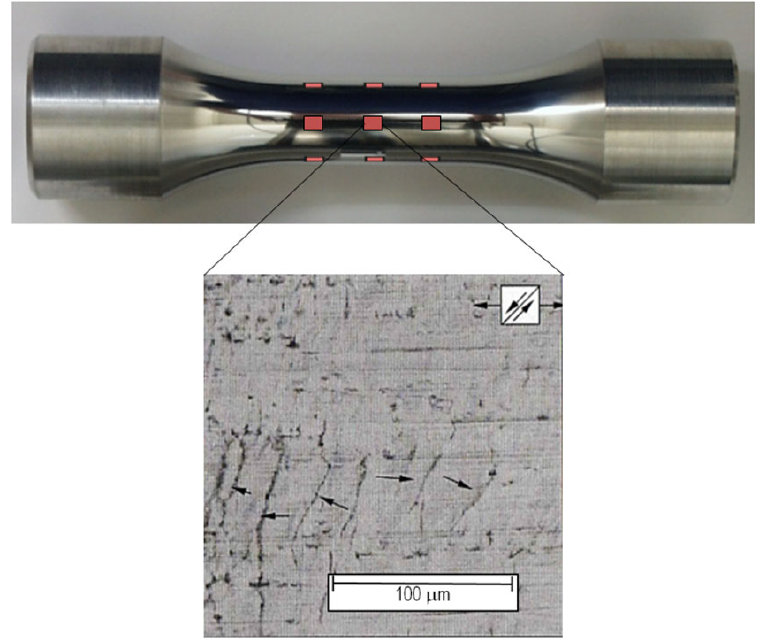
Figure 10. Fatigue test specimens were observed in 12 different places. The surface of the specimen is shown after being loaded with a compressive tensile load, ε a = 0.6%, N = 600 cycles.